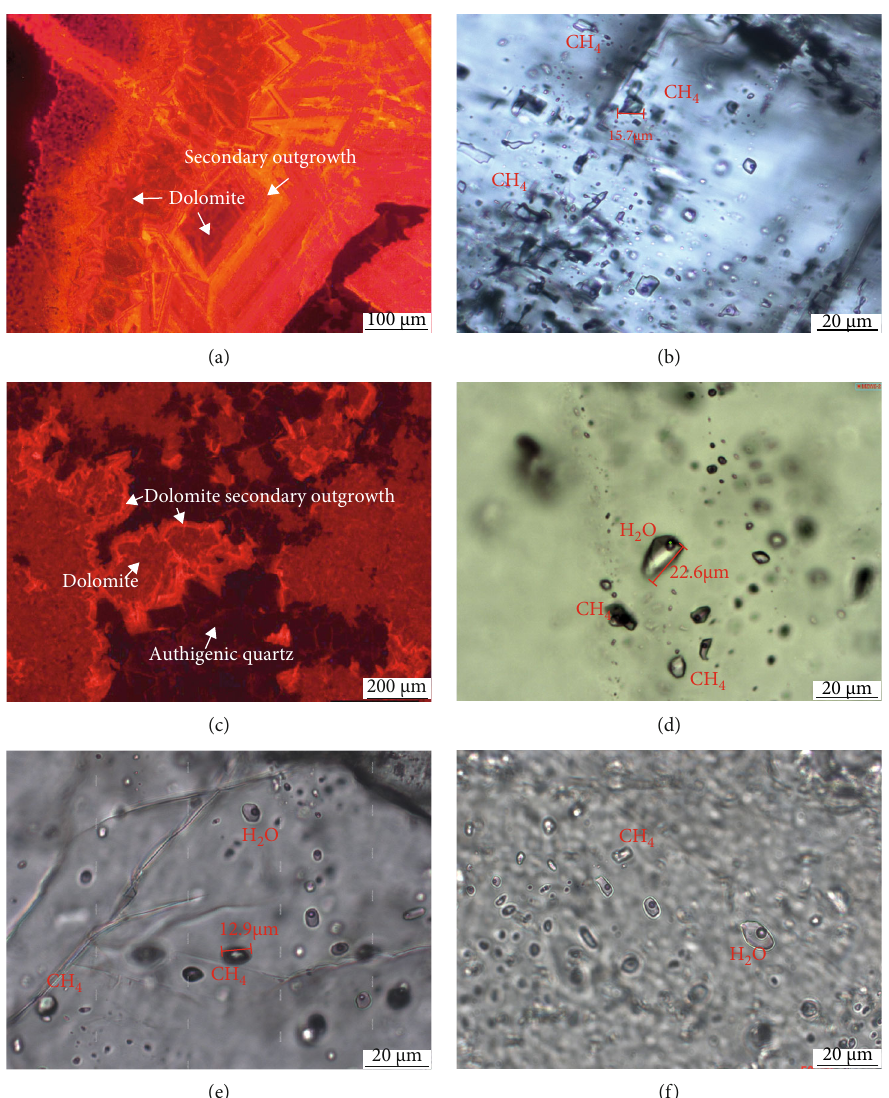
Figure 6: Microscopic characteristics of fl uid inclusion distribution and type of Z well #1 fl uid inclusion distribution area and type (sample depth is 8,159.12 m); (c) – (f) images of MS well #1 fl uid inclusion distribution area and type (sample depth is 8,055.27